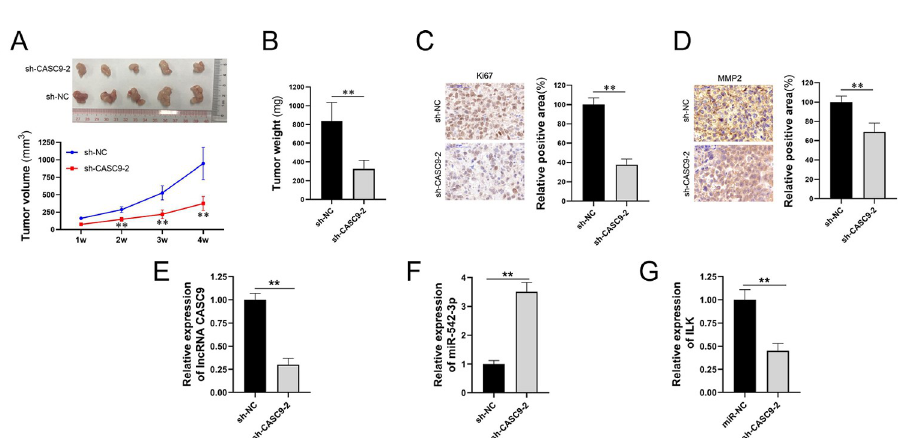
Fig 3. Downregulating lncRNA CASC9 in SW620 xenograft tumor inhibits SW620 proliferation. SW620 with stable down-regulation of lncRNA CASC9 were inoculated into nude mice to establish xenograft tumor models. Two groups were designed, sh-NC was the normal group, (i.e., control group), and the other one was an experimental group with which stable down-regulation of lncRNA CASC9 xenograft tumor. Black represents sh-NC and grey represents sh- CASC9 -2 in histograms. (A)Growth curves of xenograft tumors were drawn respectively in 1, 2, 3, 4 weeks, and tumor volume was inhibited in the sh- CASC9 -2 subset. The blue represents sh-NC and red represents sh- CASC9 -2 in the line chart. (B)Tumor weights were detected at last, and the tumor in the sh- CASC9 -2 subset was lighter than sh-NC. Ki67 and MMP2 were detected by IHC. (C) Ki67 in positive cells significantly reduced in the sh- CASC9 -2 subset, (D) while the decrease of MMP2 in positive cells was not so obvious. The histograms are the quantitative analysis of pictures. (E&F&G) Compared to the NC subset, the expression of lncRNA CASC9 and ILK in the sh- CASC9-2 subset was significantly downregulated, while the expression of miR-542-3p in the sh-CASC9-2 subset was significantly upregulated. Scale bar = 50 μ m. � P < 0.05 and �� P < 0.01.